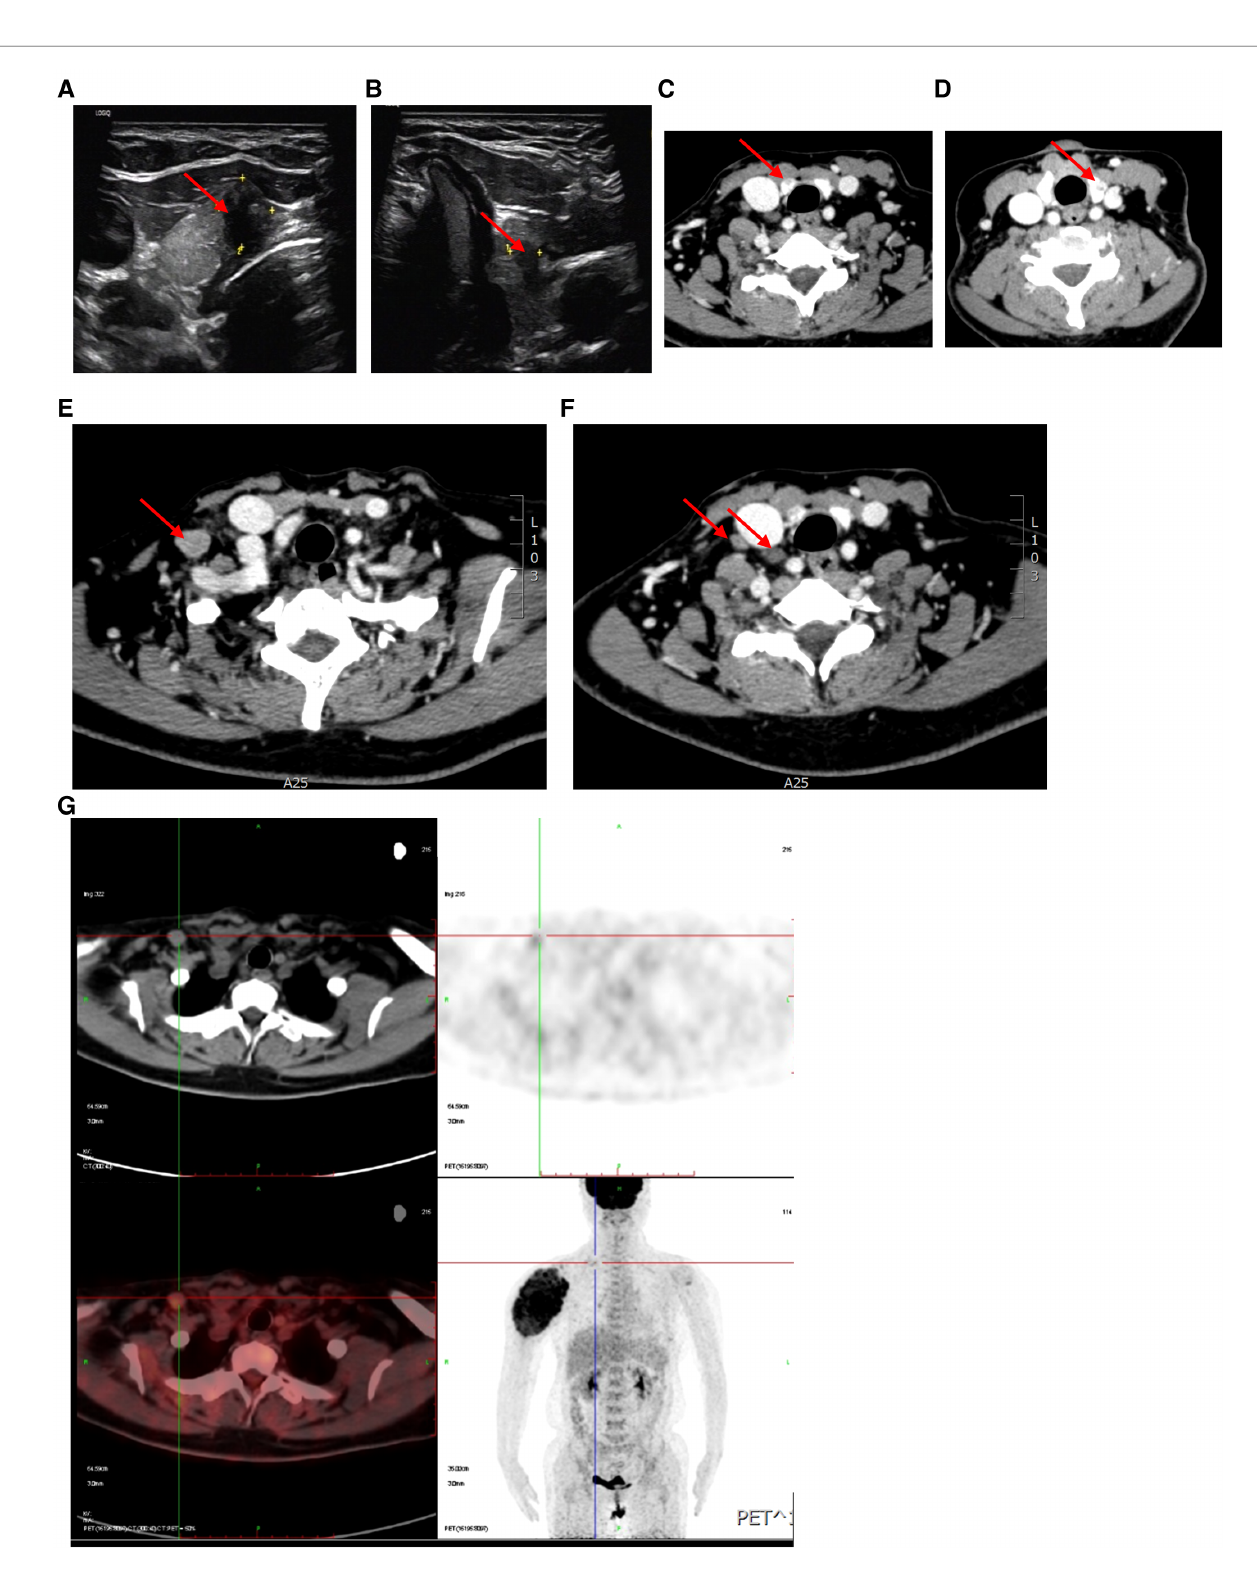
FIGURE 3 Examinationofthyroid and cervical lymph nodes. ( A , B ) CE-US of thyroid showed within the upper portion of the left thyroid lobe was a hypoechoic,taller than wide, irregular nodule (red arrow), deeming it a TI-RADS 5. ( C , D ) Contrast-enhanced CT of the thyroid identi fi ed hypodense nodules within both thyroid lobes. ( E , F ) CT scan showed high density nodules in the right lateral cervical region. ( G ) 18 F-FDG PET/CT images showed increased uptake in right supraclavicular